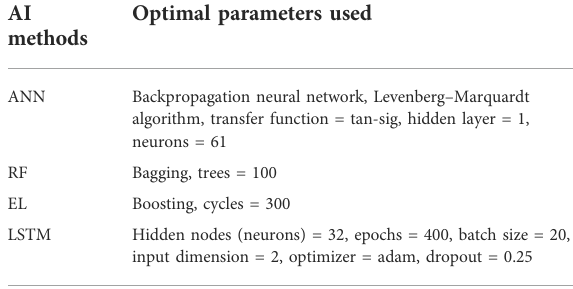
TABLE 2 Optimal parameters used for designing different training